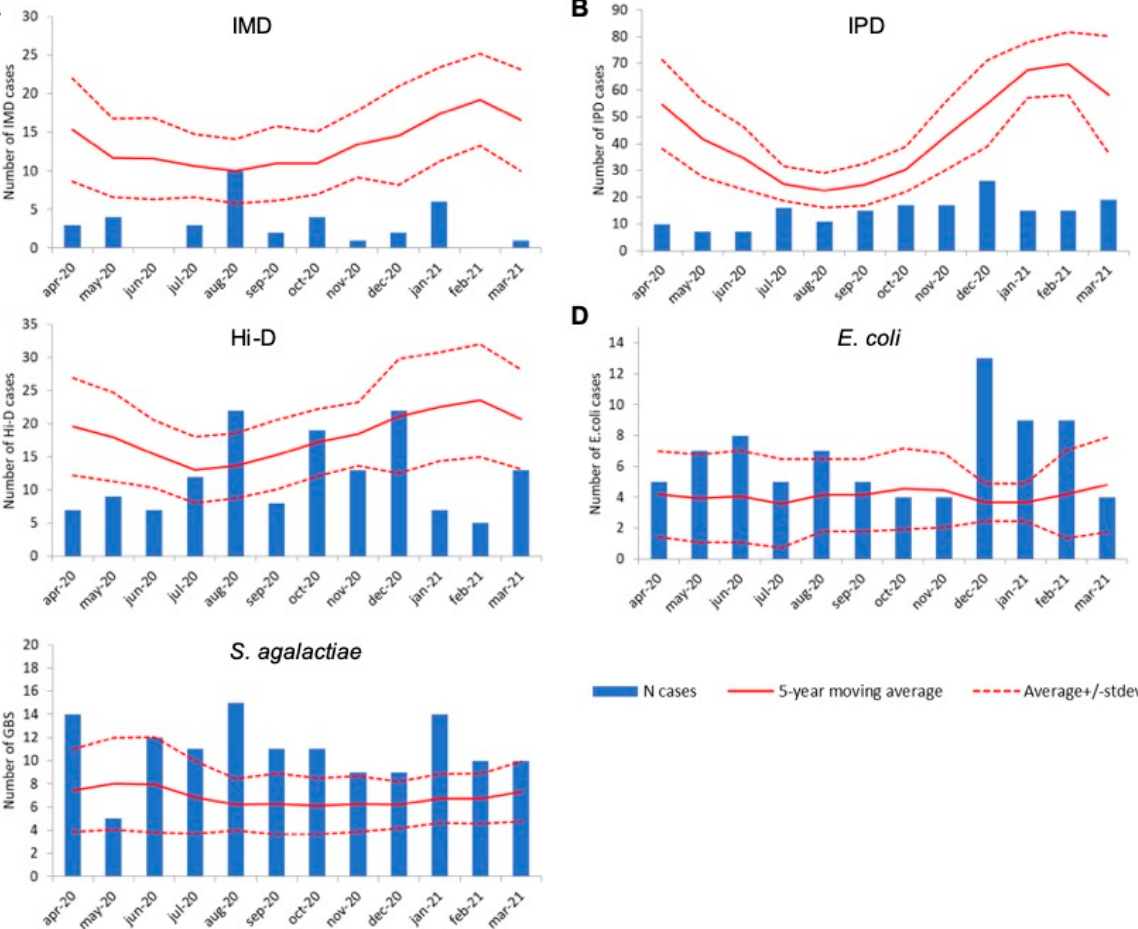
Figure 1. Number of invasive disease cases by month in the first COVID-19 year (2020–2021; bars) based on bacteriological surveillance, the 5-year moving average in pre-COVID years (solid line) and its standard deviation for the pre-COVID period (dashed line) for ( A ): N. meningitidis (IMD); ( B ): S. pneumoniae (IPD); ( C ): H. influenzae (Hi-D); ( D ): E. coli ; ( E ): S. agalactiae . Note that the y-axis differs between pathogens.